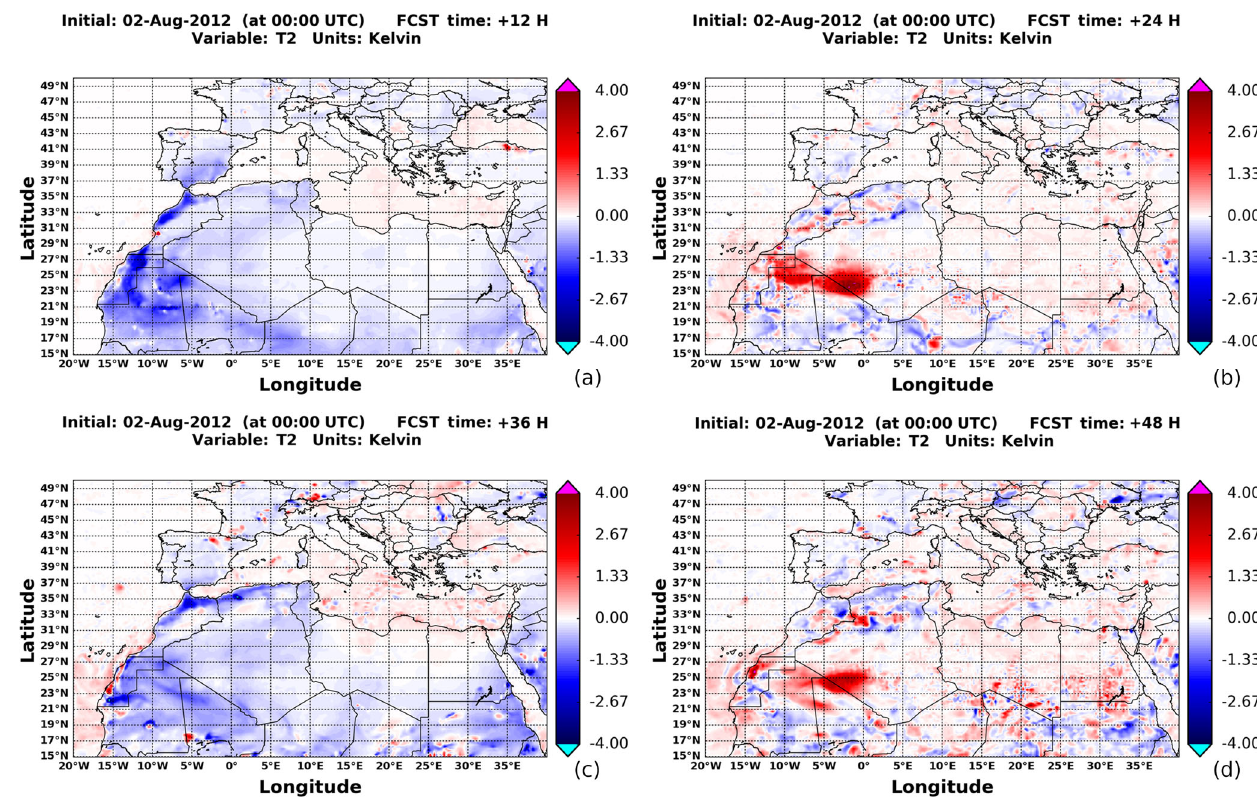
Figure 7. Spatial patterns of temperature differences at 2m, between the RADON and RADOFF configuration of the NMMB-MONARCH model, for the (a) 12, (b) 24, (c) 36 and (d) 48h forecast of the 00:00UTC cycle on 2 August